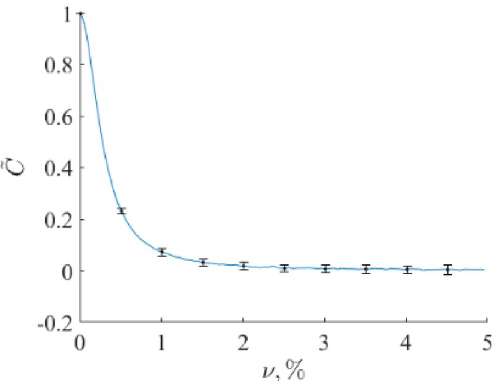
Figure 9. Dependence of the target component (blood) volume fraction restoration error on the additive noise amplitude ν . Here, the true volume fraction value is equal to